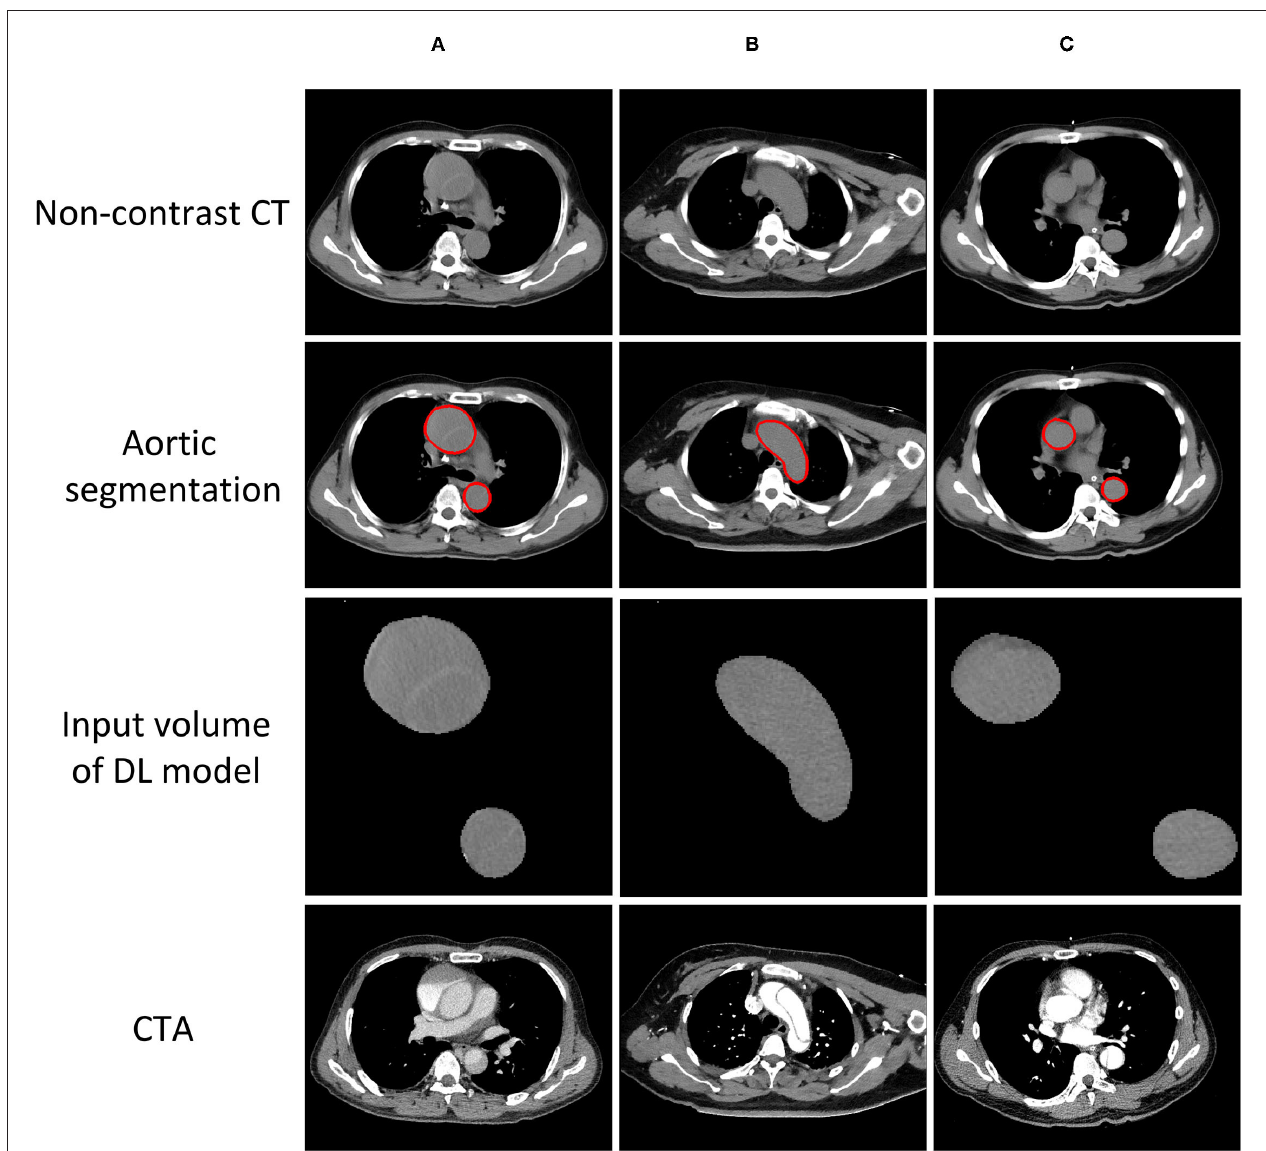
FIGURE 6 | AD cases with CT images. (A) Successfully detected by all the radiologists and the model. (B) Successfully detected by our model, but neglected by one of the radiologists. (C) Neglected by both our model and all the radiologists.